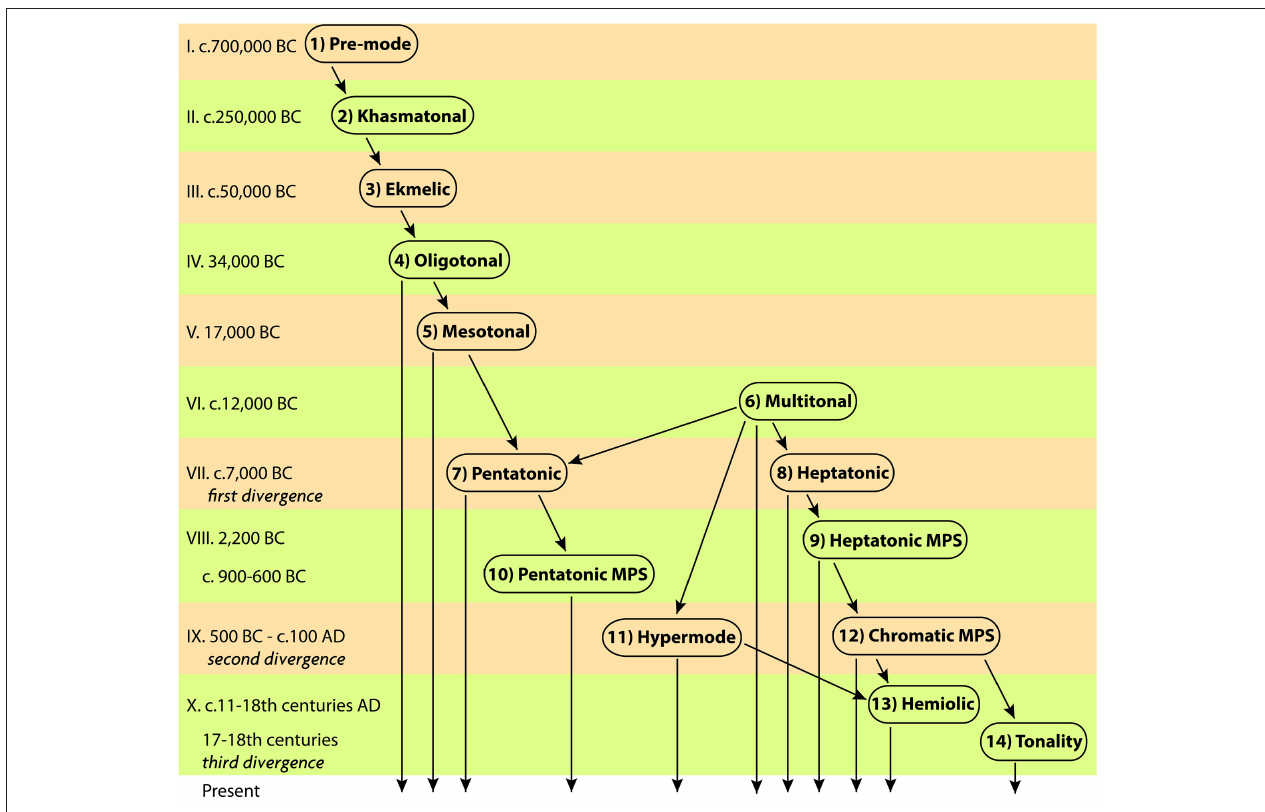
Figure 5 | 14 schemes of tonal organization that occur through 10 stages. Stages 1–6 are cumulative until the divergence between pentatony and heptatony. Second divergence occurred between chromatic and diatonic MPSs, bringing to life hypermode. Chromatic MPS produced yet another divergence between hemiolic modality and tonality. The importance of this is that competence in first six schemes is shared by all music users, who can switch between operating in any of them and their “native” music system: i.e., a mother raised on music of Western tonality employs khasmatonal organization in her motherese. Divergence, on the other hand, requires learning of a scheme that is diverged in relation to the music user’s native